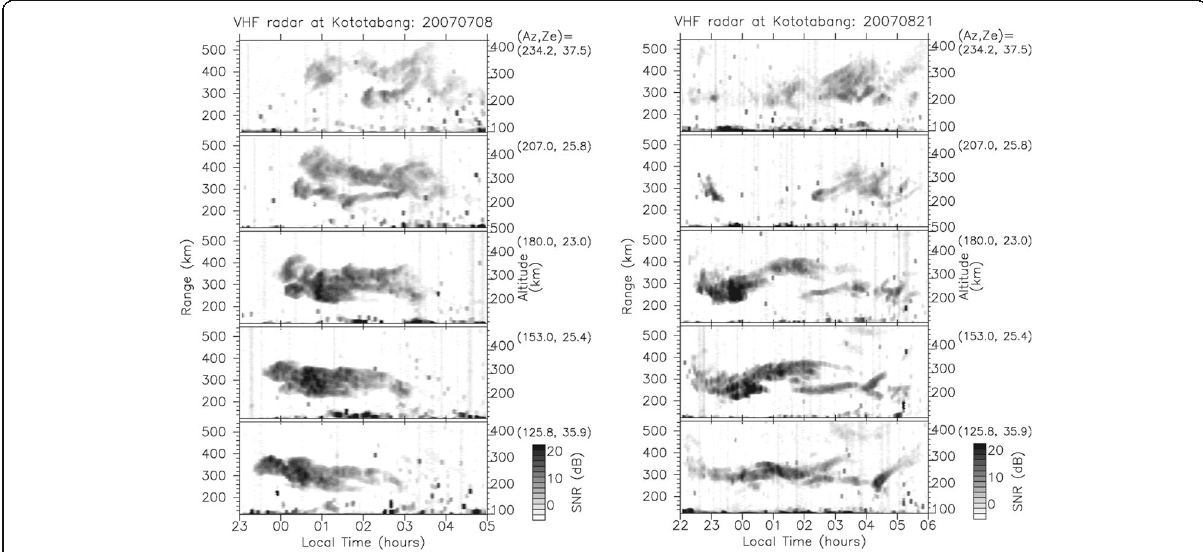
Fig. 2 Range-time-intensity plot of the FAI in the F region observed on the beam with azimuth of 234.2°, 207.0°, 180.0°, 153.0°, and 125.8° (from top to bottom panels) with the 30.8 MHz radar at Kototabang, Indonesia on the nights of (left) August 21, 2007, and (right) July 8, 2007. Left vertical axis shows the range from the radar and the right axis shows the altitude at which the radar beam is perpendicular to the geomagnetic field. (after Otsuka et al.